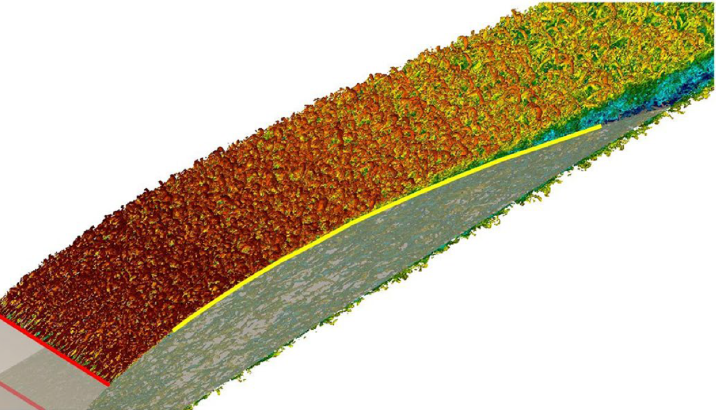
Figure 1. Instantaneous visualization of coherent vortical structures [34] around a NACA4412 wing section at Re c = 400,000, colored by streamwise velocity ranging from (dark blue) − 0.2 to (dark red) 1.7. The yellow line indicates the extent of the control region (with uniform blowing on the suction side), whereas the red one denotes the tripping location [35,36]. Figure extracted from Ref. [32], with permission of the publisher (Springer